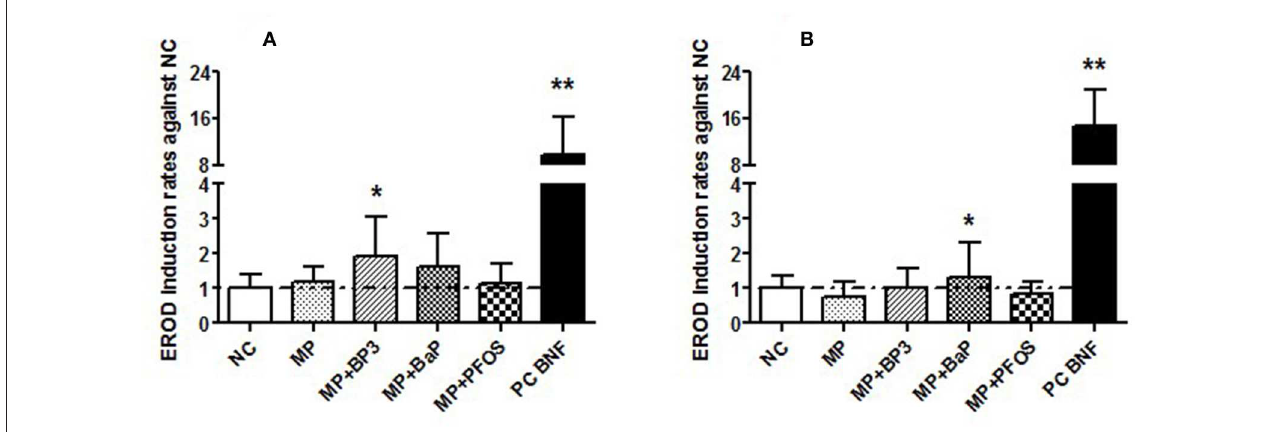
FIGURE 3 | EROD activity in 96h old zebrafish ( Danio rerio ) embryos exposed to microplastic (MP) and microplastic spiked with benzophenone 3 (MP + BP3), benzo[a]pyrene (MP + BaP), perfuorooctane sulfonate (MP + PFOS), and β -naphthoflavone as a positive control (PC BNF) after 3h pulse (A) or 96h continuous exposure (B) . EROD activities are given relative to negative controls (NC) as means ± SD ( n = 3; ANOVA on ranks: * p < 0.05, ** p < 0.01).